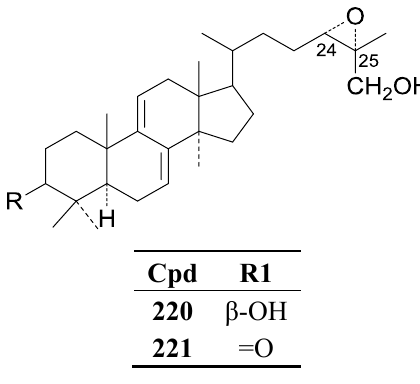
Figure 22. Structure of compounds 220 – 221 .